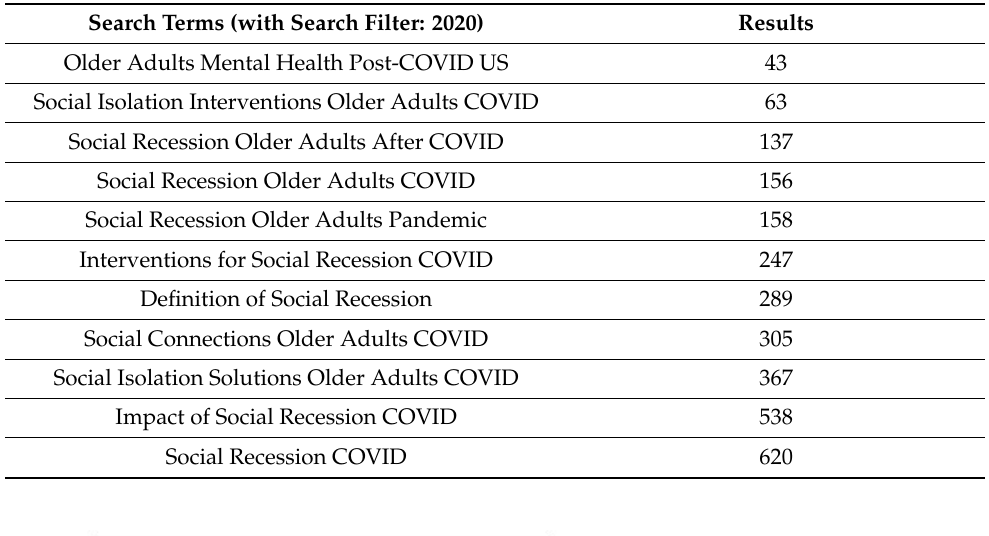
Table 1. Examples of Search Terms and Results Returned.